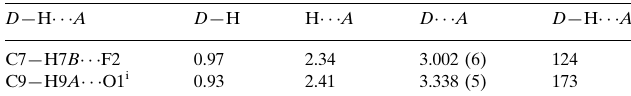
Hydrogen-bond geometry (A˚ , (cid:2)